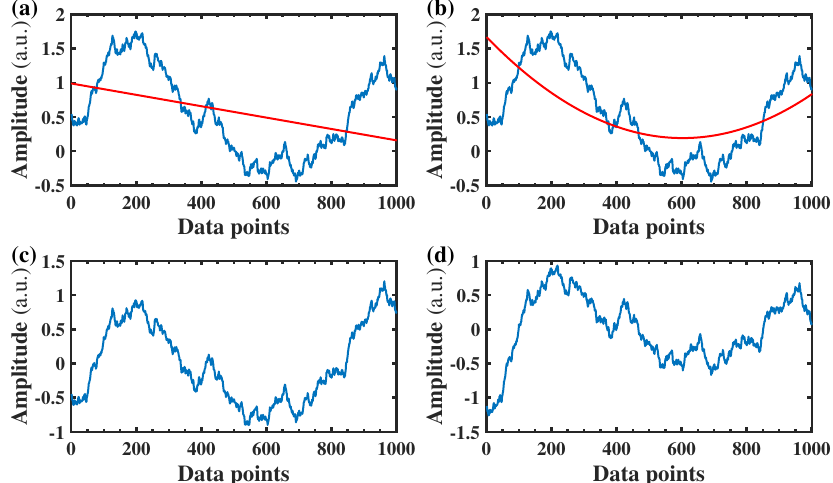
Figure 2. An example of the flattening process: The original profile (blue line) and the fitted polyno- mial line (red line) with ( a ) 1-order, ( b ) 2-order; the flattened profile by subtracting the polynomial with ( c ) 1-order, ( d )